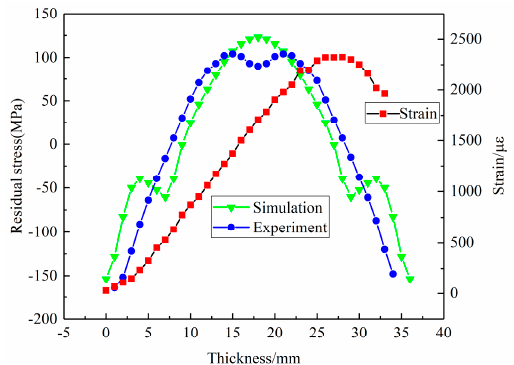
Figure 8. Comparisons of surface stresses distributions for the S11, S22 stress components between experimental data through X-ray diffraction method and simulation results on the paths. ( a ) 1/2 X Path; ( b ) 1/2 Y Path.